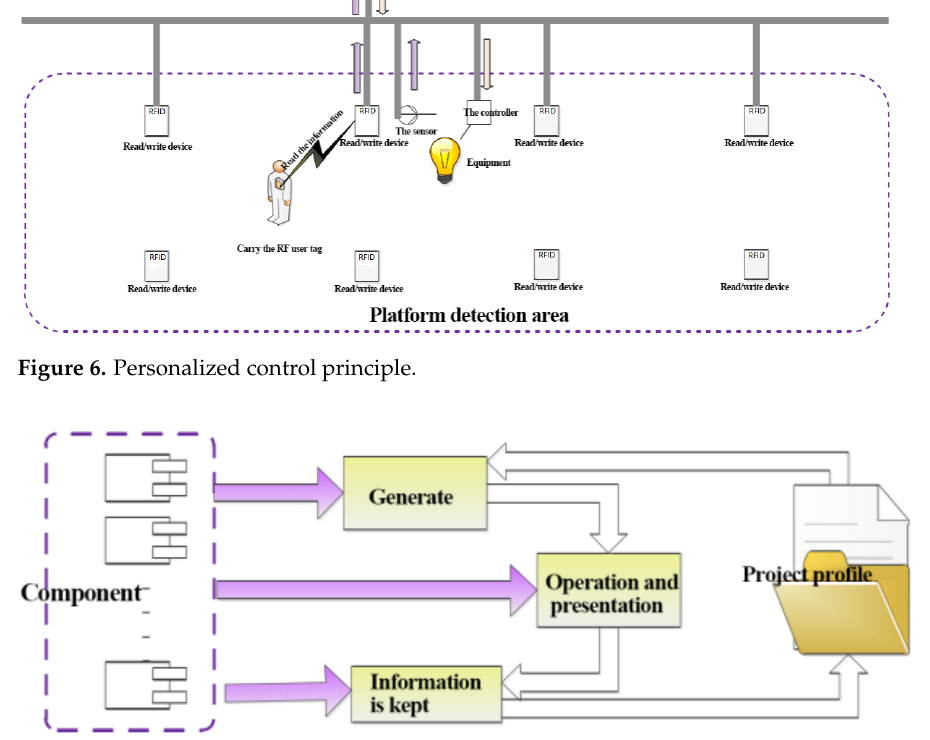
Figure 9. Privilege configuration principle. 4. Application of Artificial Intelligence Technology in Intelligent Building Lighting Control 4.1. The Pre-Processing Steps Decompose the image by convolving the image function f ( x , Y) with the neighborhood sub-function h ( m , n ). If the filter function expression is g ( x , Y)—the